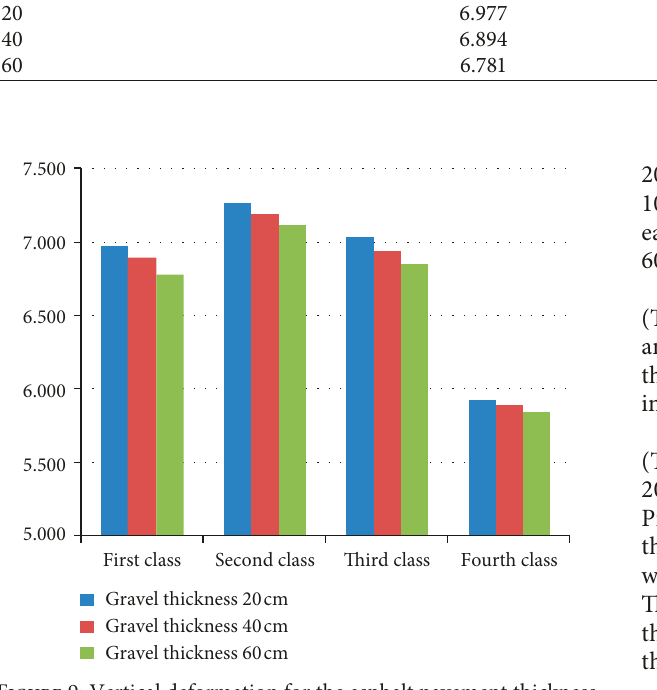
Figure 9: Vertical deformation for the asphalt pavement thickness of